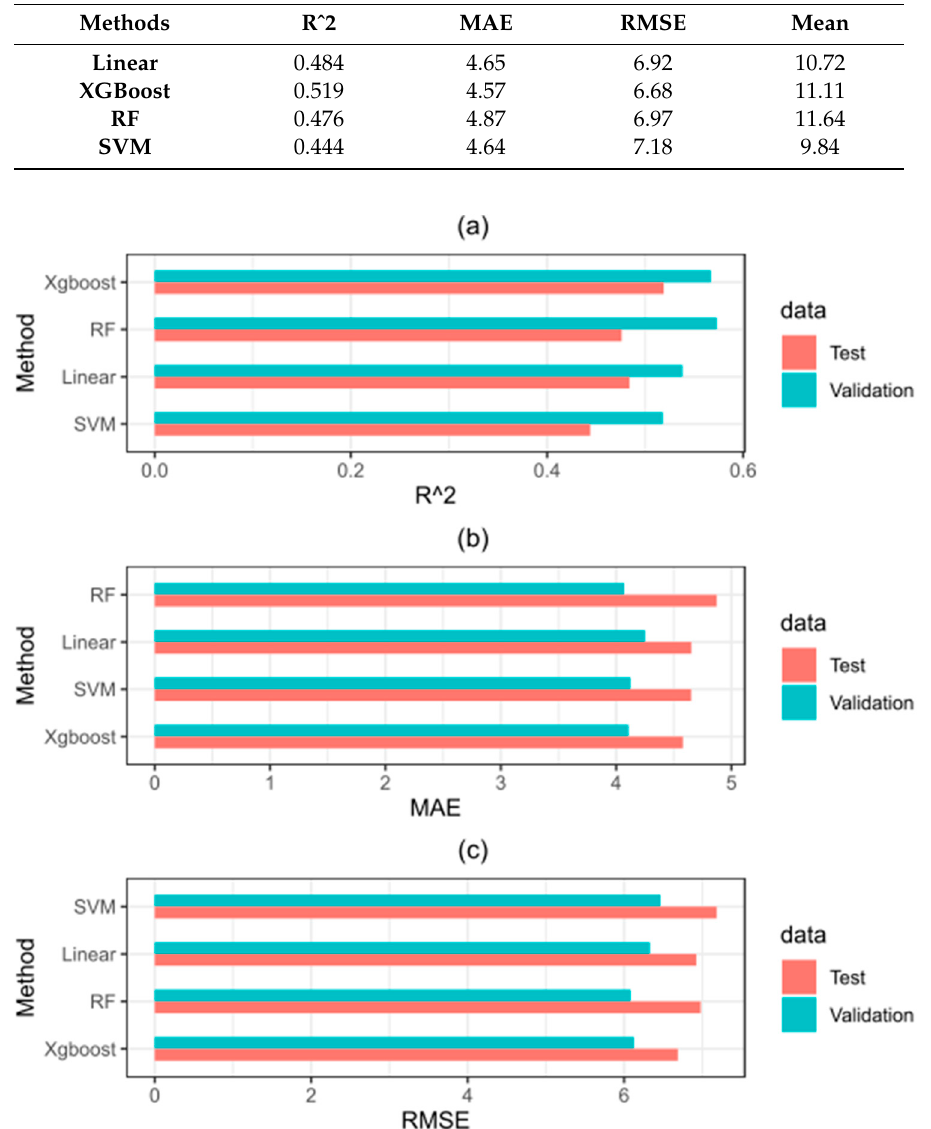
Figure 10. Accuracy metric comparisons including (a) R2, (b) MAE, and (c) RMSE for each method.